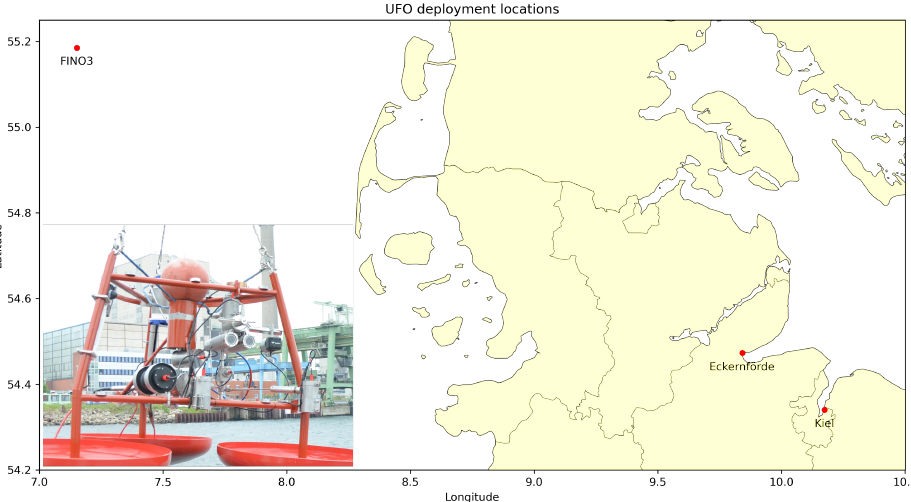
Figure 1. The prototype of the Underwater Fish Observatory (UFO), shortly before deployment in the Kiel Fjord, and a map displaying the platform’s deployment locations to